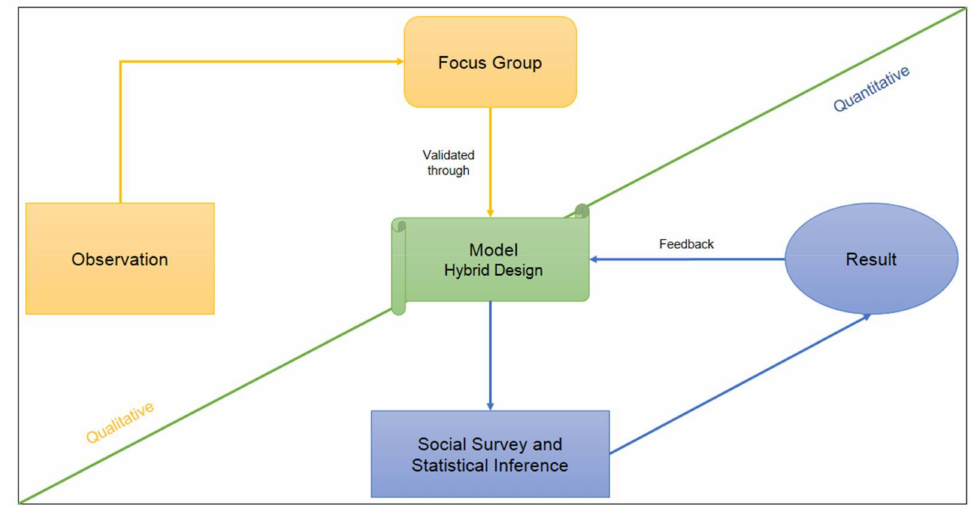
Figure 4. Methodological sequence established for the construction of the model. Author’s elaboration.